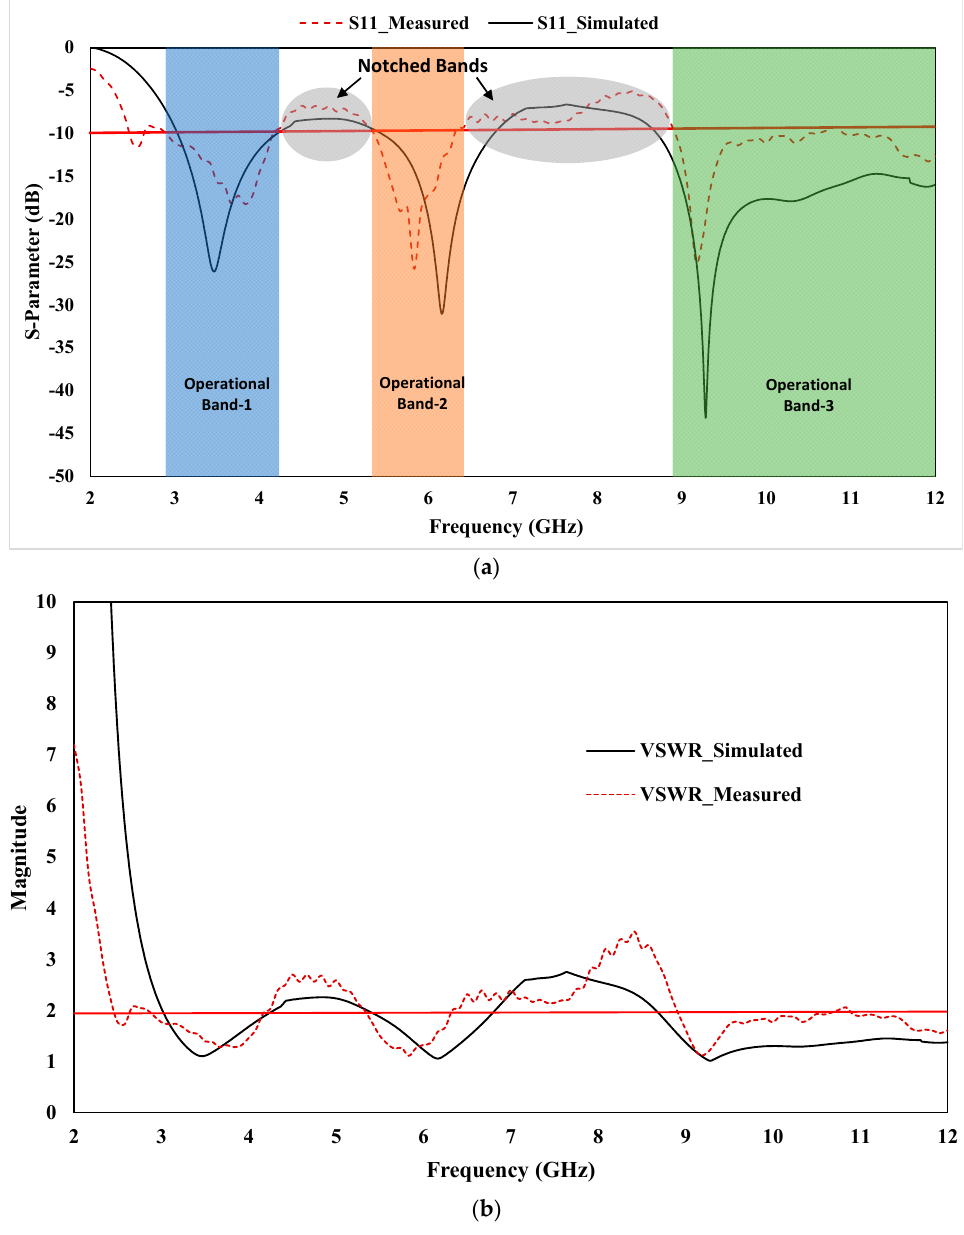
Figure 11. Simulated and measured S-parameter response of the proposed antenna ( a ) Return-loss and ( b ) VS.WR.